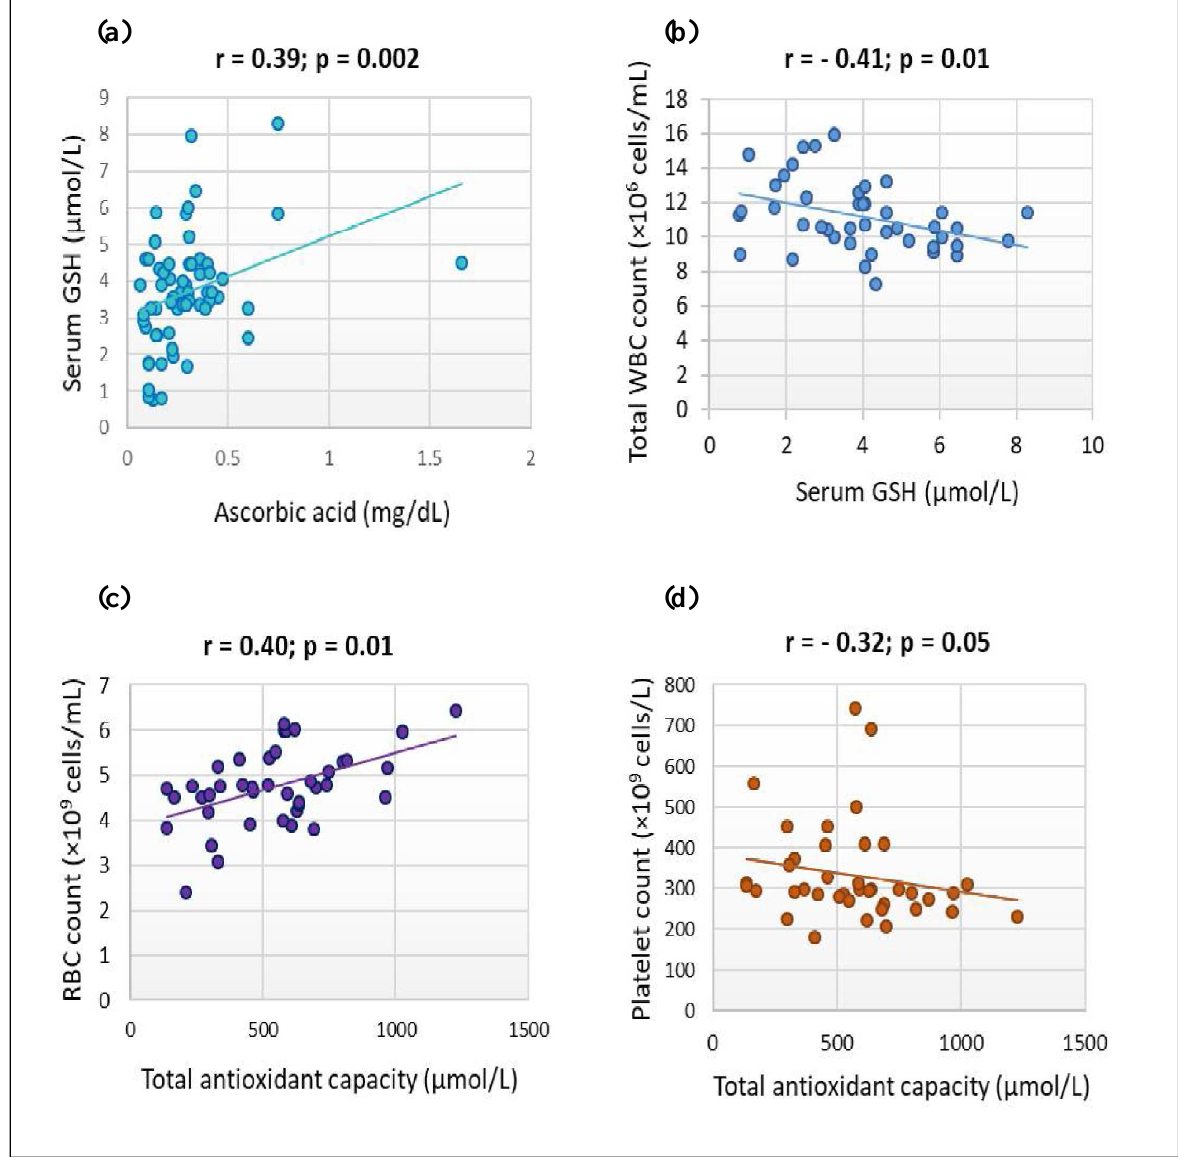
Figure 3: Significant correlations between the levels of (a) Ascorbic acid and serum GSH; (b) Total WBC count and serum GSH; (c) RBC count and total antioxidant capacity; and (d) Platelet count and total antioxidant capacity in patients with acute coronary syndrome [Spearman